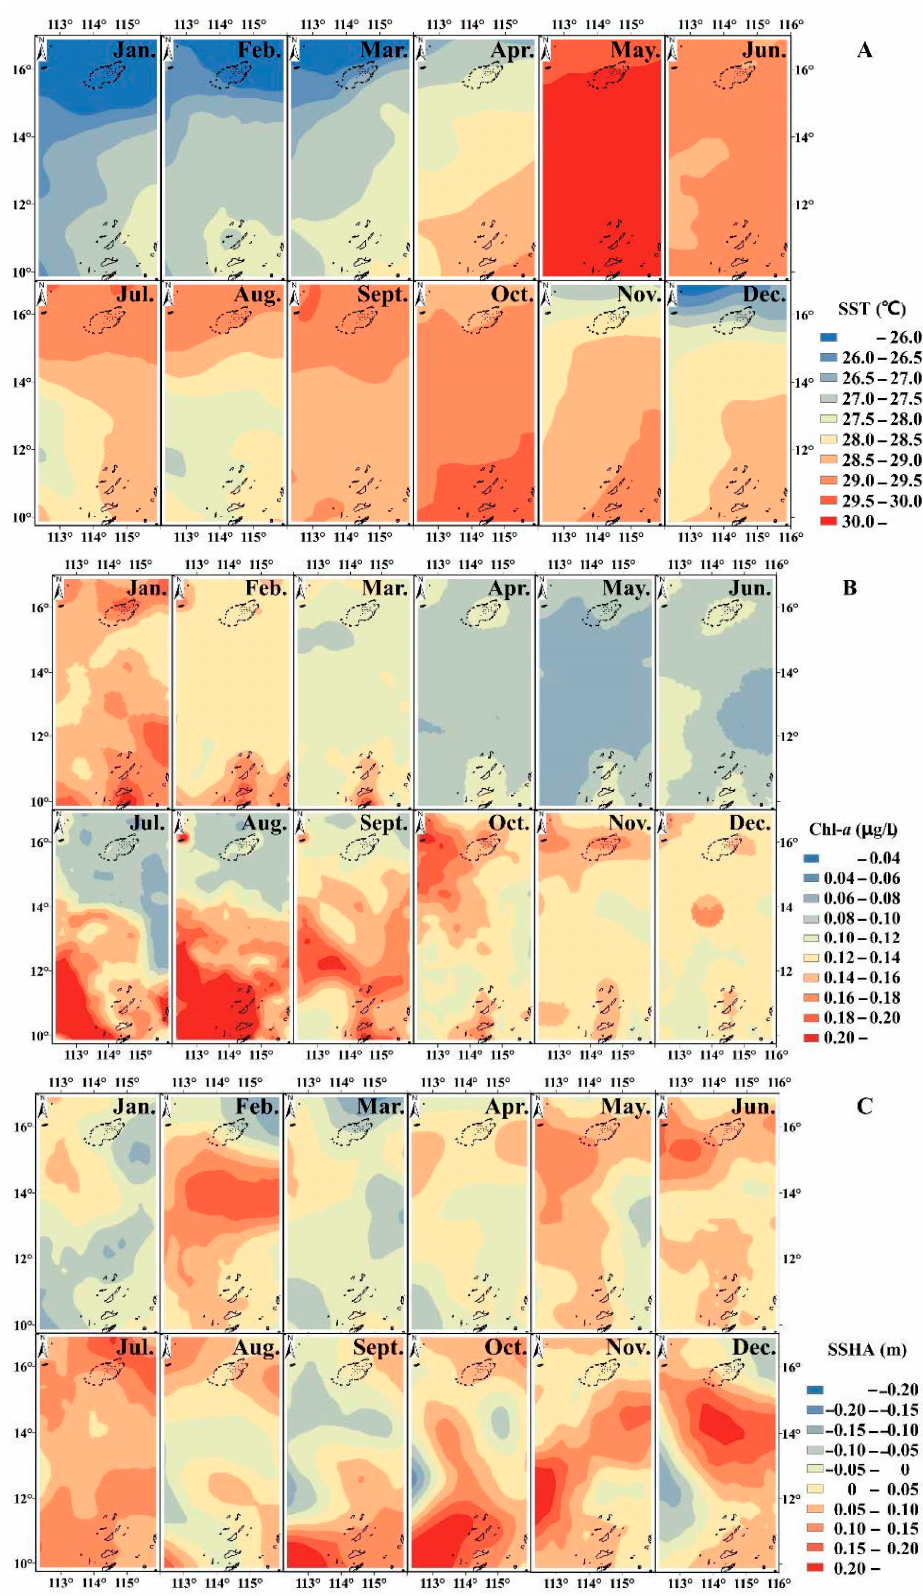
Figure 3. Spatio-temporal distribution of environmental conditions, including ( A ): sea surface temperature (SST); ( B ): Chl- a (chlorophyll- a concentration); and ( C ): sea surface height anomaly